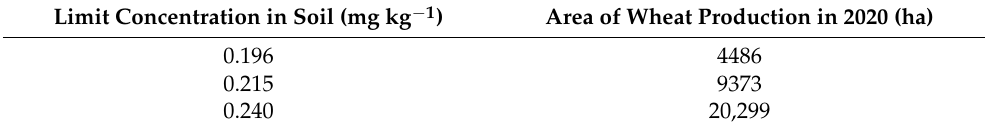
Table 6. Area of winter wheat production in 2020 (Swedish Board of Agriculture, Jönköping, Sweden) within areas of the digital soil map (DSM) with cadmium (Cd) concentrations below the limits corresponding to the 30th, 40th, and 50th percentile of laboratory-analyzed soil Cd concentrations in the NV